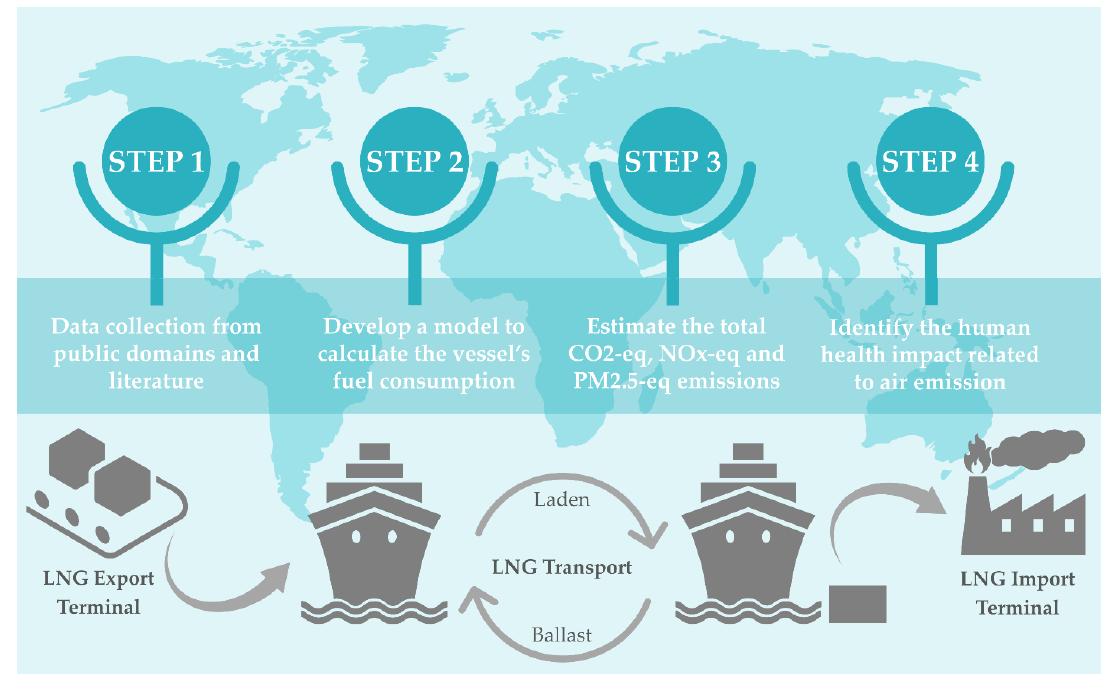
Figure 13. Steps of life cycle air emissions using LNG maritime transport emission quantification tool.